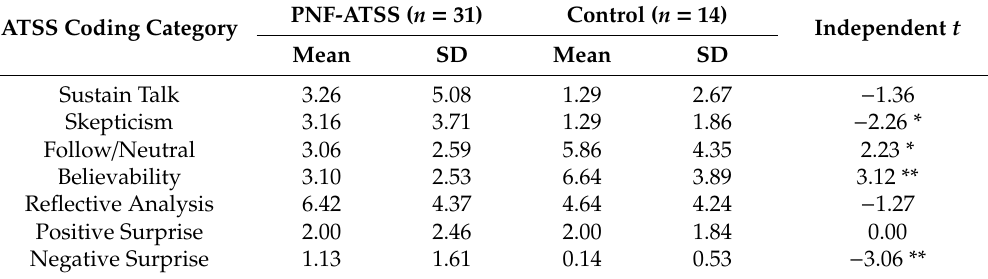
Table 7. Mean di ff erences on coding categories as a function of intervention condition. ATSS Coding